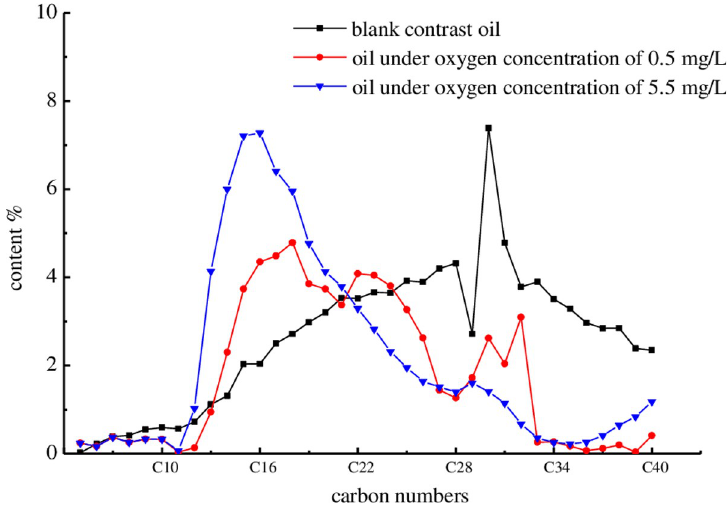
Fig 9. Carbon distribution curve of biodegraded oil with different oxygen concentration.